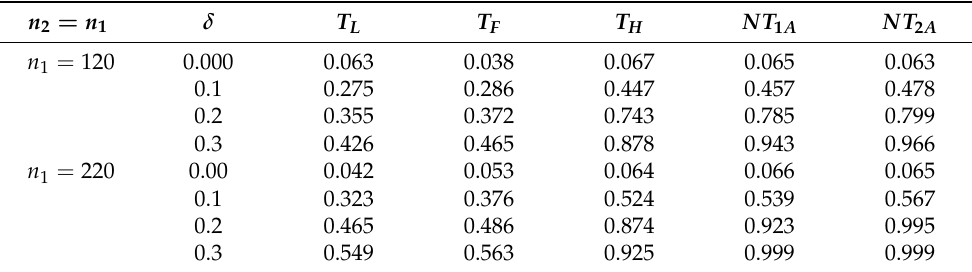
Table 8. Size and power of five methods under randomized signal in Setting 2 M ( 40,6 ) . n 2 = n